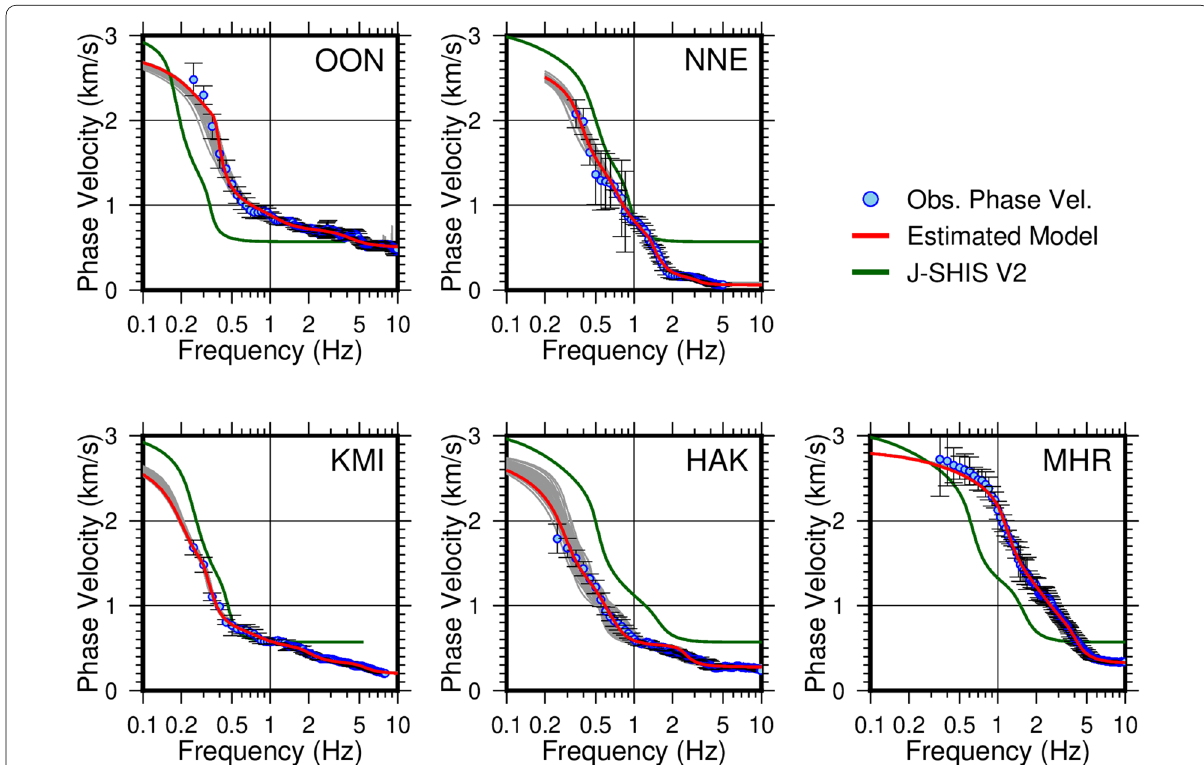
Fig. 4 Comparison of observed phase velocities and the theoretical dispersion curves. The blue circles represent the observed phase velocities. The theoretical phase velocity dispersion curve of the fundamental mode of the Rayleigh wave by the best model is plotted with the red line. Other models with residual values smaller than twice the best model are indicated by gray lines. The theoretical dispersion curve based on the J-SHIS V2 model (Fujiwara et al. 2012) is also plotted by the green